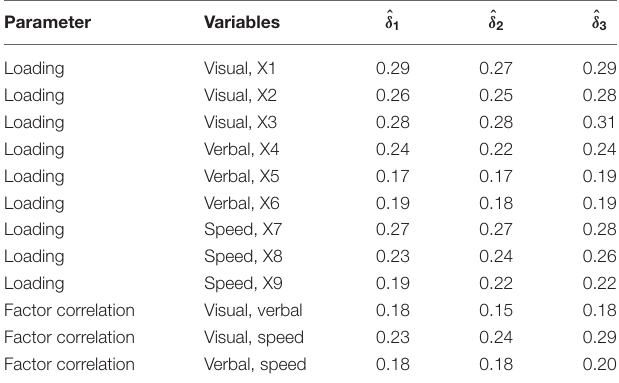
TABLE 6 | Results from the example